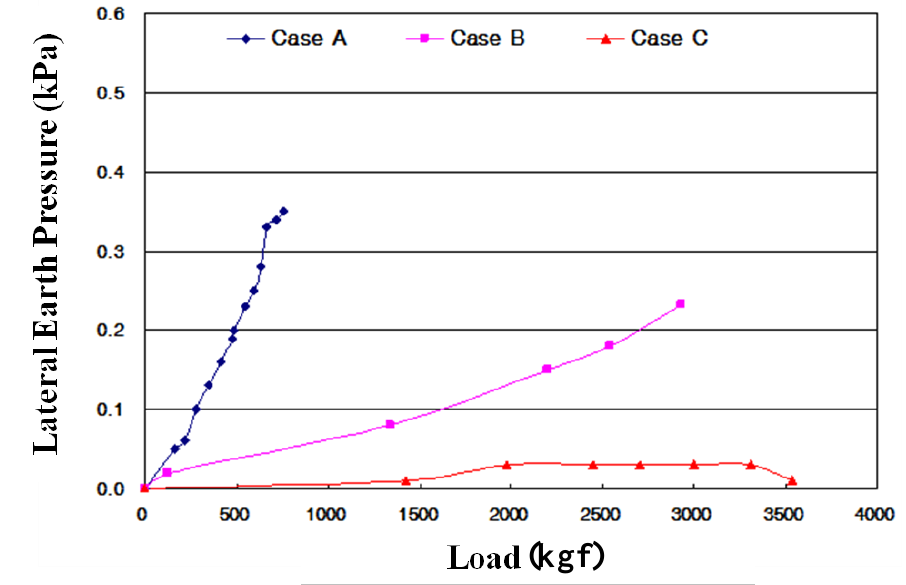
Figure 11. Lateral earth pressure (kPa).